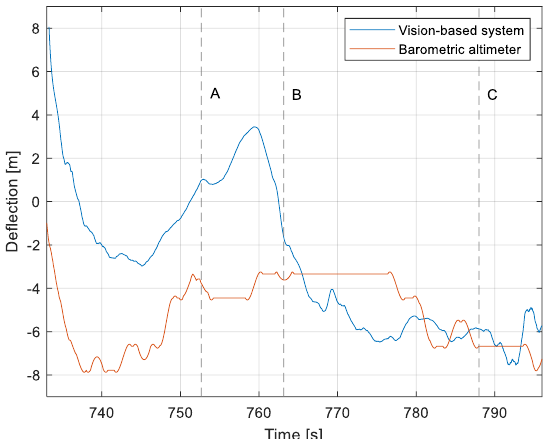
Figure 20. Linear lateral deflection from the center line: Flight no. 3 (markers A – C correspond to the moment of recording the images in Figure 13.